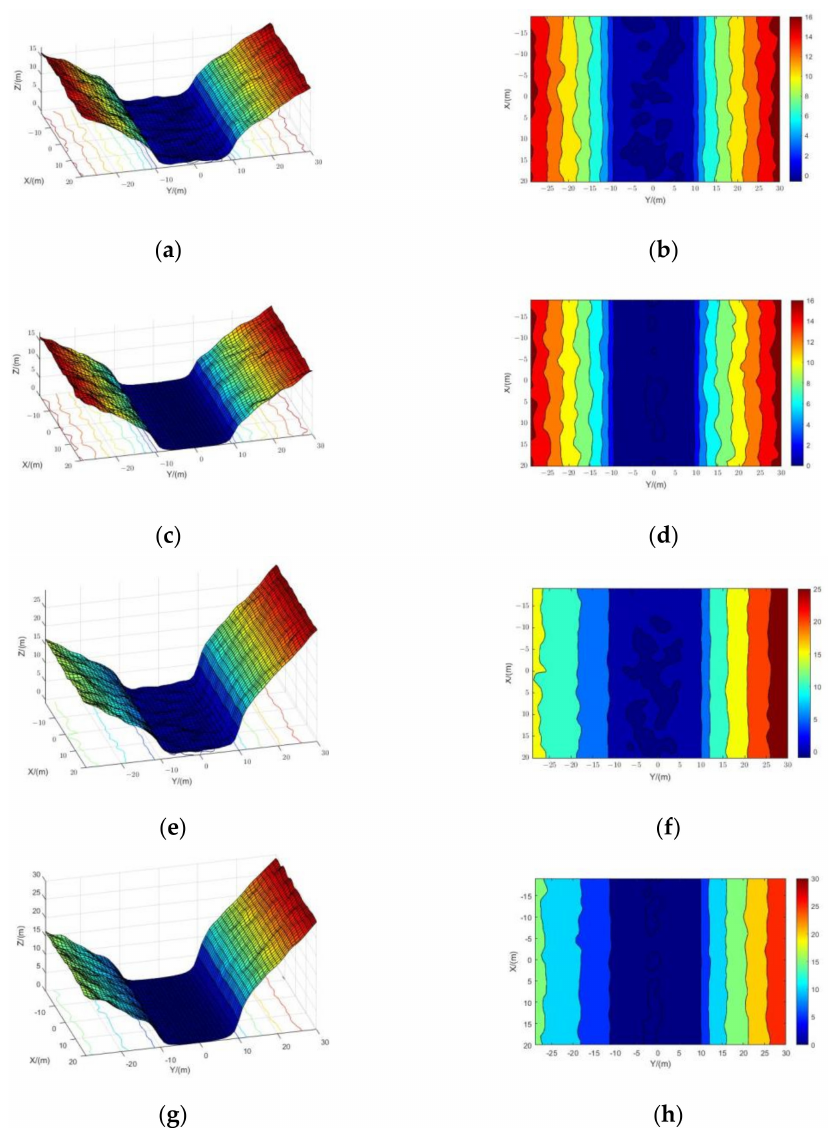
Figure 3. Canyon and valley composite rough surface simulation results: ( a ) geometry of canyon, α 1 = 30 ◦ , α 3 = 30 ◦ ; ( b ) contour map of canyon, α 1 = 30 ◦ , α 3 = 30 ◦ ; ( c ) geometry of valley, α 1 = 30 ◦ , α 3 = 30 ◦ ; ( d ) contour map of valley, α 1 = 30 ◦ , α 3 = 30 ◦ ; ( e ) geometry of canyon, α 1 = 30 ◦ , α 3 = 45 ◦ ; ( f ) contour map of canyon, α 1 = 30 ◦ , α 3 = 45 ◦ ; ( g ) geometry of valley, α 1 = 30 ◦ , α 3 = 45 ◦ ; ( h ) contour map of valley, α 1 = 30 ◦ , α 3 = 45 ◦